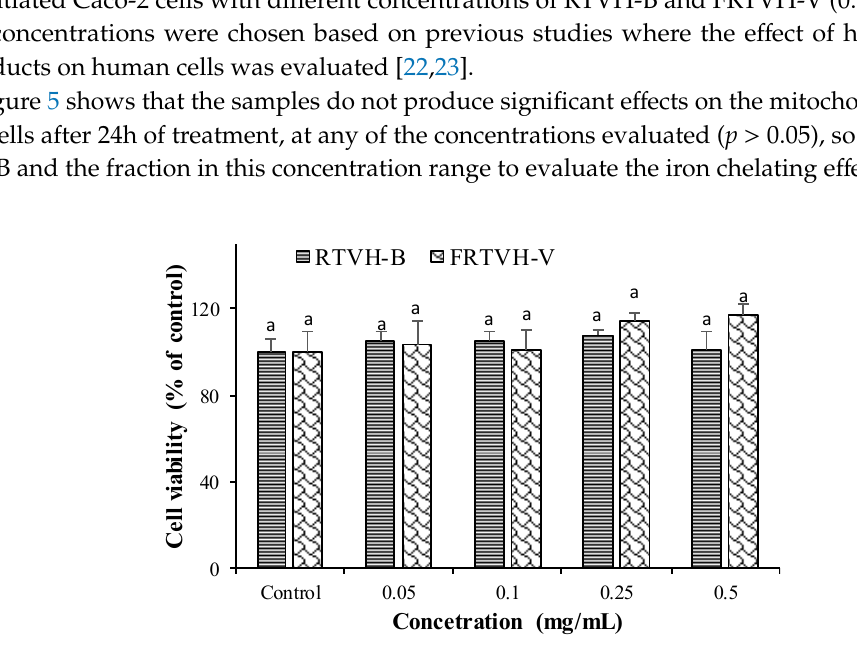
Figure 5. Effect of RTHV-B and FRTVH-V on cell viability (MTT assay) in differentiated Caco-2 cells after 24 h treatment. Values are expressed as means ± standard deviation ( n = 4). Different superscript letters denote statistically significant differences among treatments ( p < 0.05).